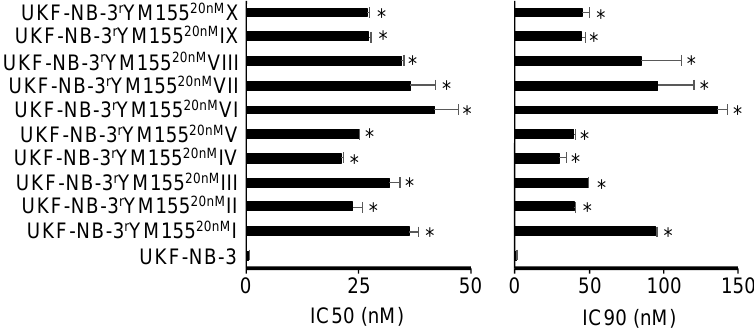
Figure 1. YM155 concentrations that reduce the viability of UKF-NB-3 and its YM155-adapted sublines by 50% (IC50) or 90% (IC90) as determined by MTT assay after 120 h of incubation. The sublines display significantly increased YM155 resistance. Numerical values are presented in Table S1. * p < 0.05 relative to UKF-NB-3.